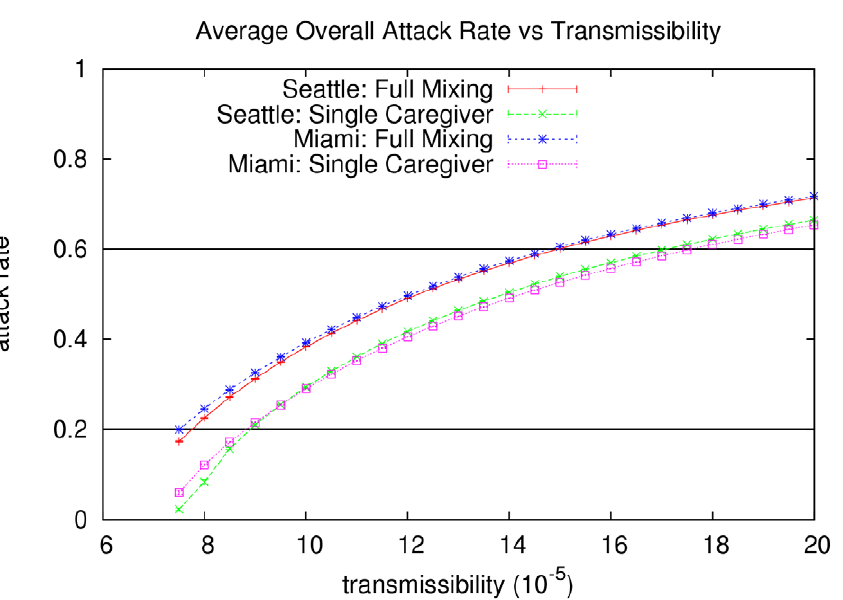
Figure 2. Mean overall infection rate (averaged over 100 runs) as a function of transmission rate t for Miami and Seattle in the full mixing and singlecaregiver case. The horizontal lines indicate the attack rates in Miami with the full mixing model under high and moderate levels of infectiousness, respectively.